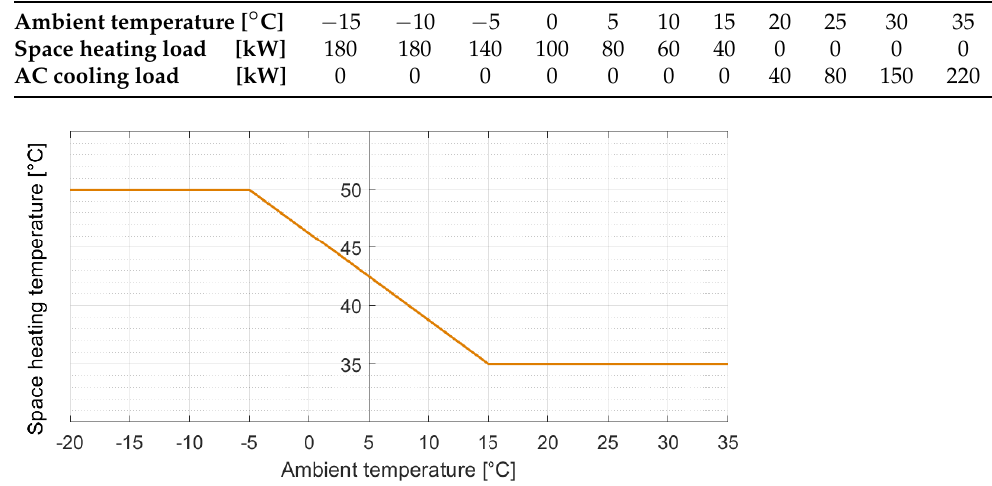
Table 3. Ambient temperature dependent space heating and AC cooling loads supplied by the integrated system.